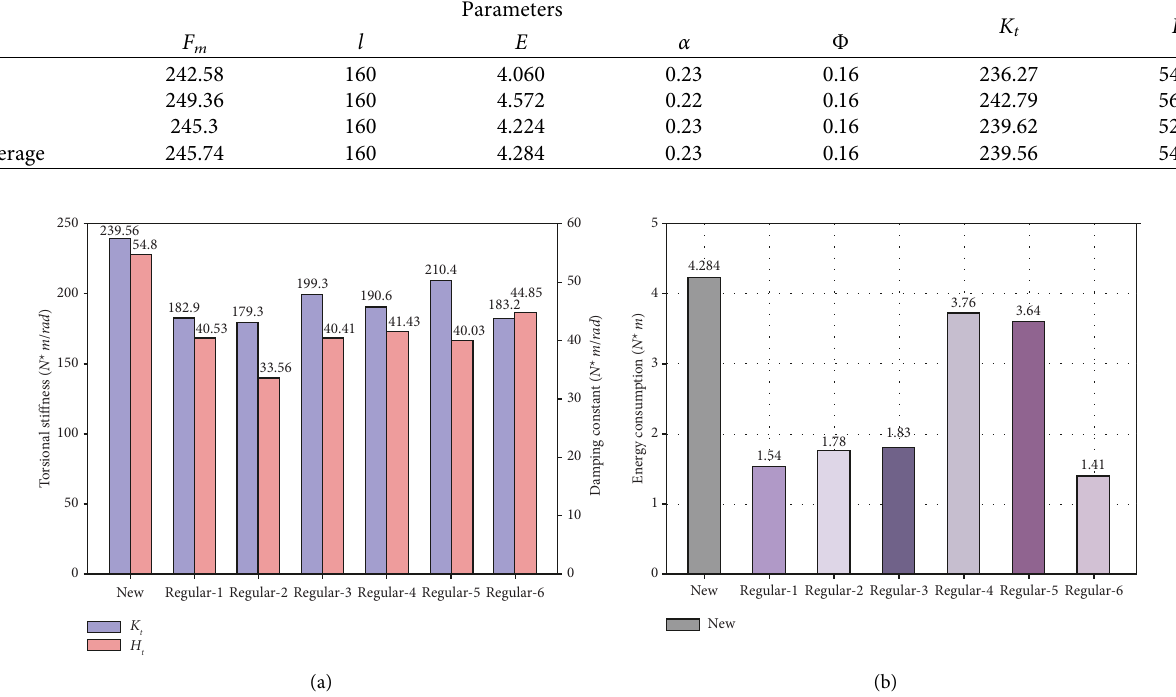
Figure 13: Comparison of test results: (a) torsional stifness and damping constant visualization comparison results and (b) energy consumption comparison visualization results.